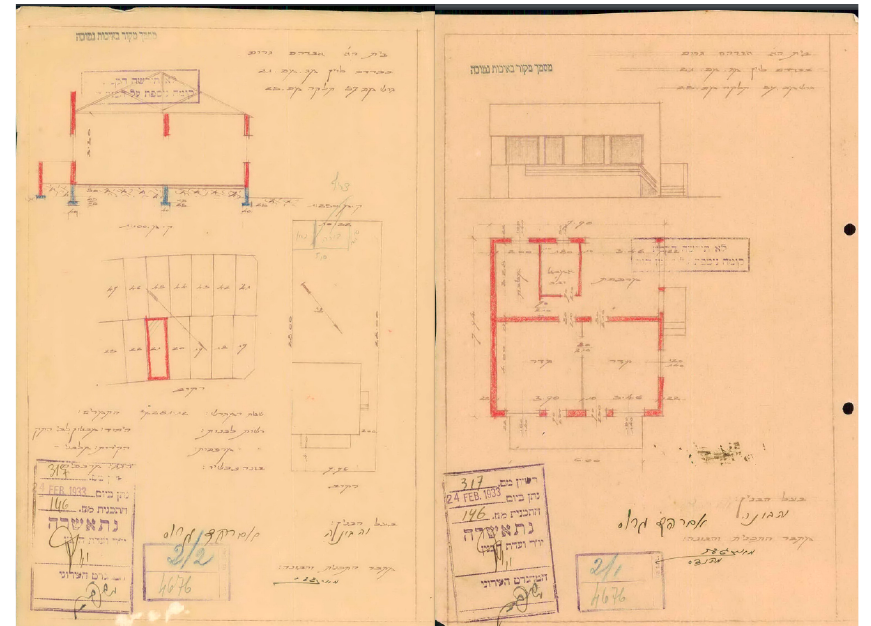
Figure 10. Building permit for the house of Abraham Gross, Levin Orchard plot number 21. Source: “Building permit for the house of Abraham Gross”, 1933.